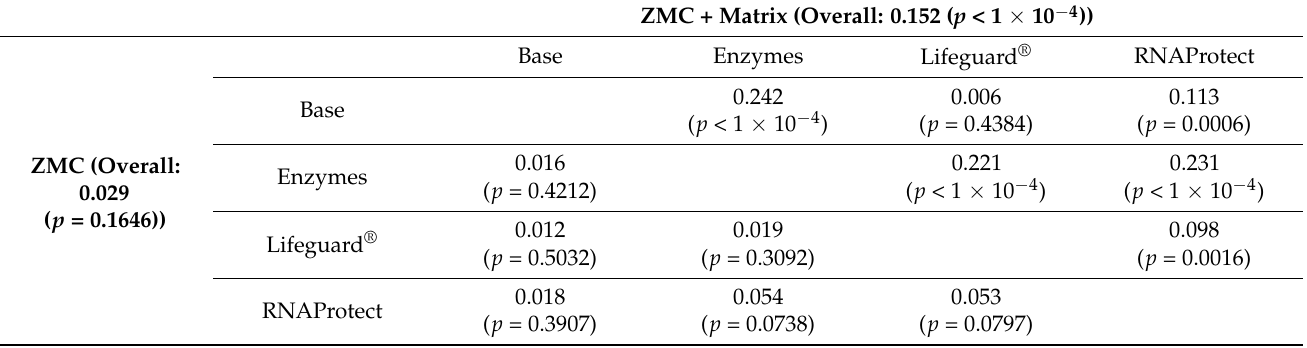
Table 2. Effect sizes and p- values for tests of pairwise bias differences for four extraction protocols in ZMC (lower triangle) and ZMC + Matrix (upper triangle)